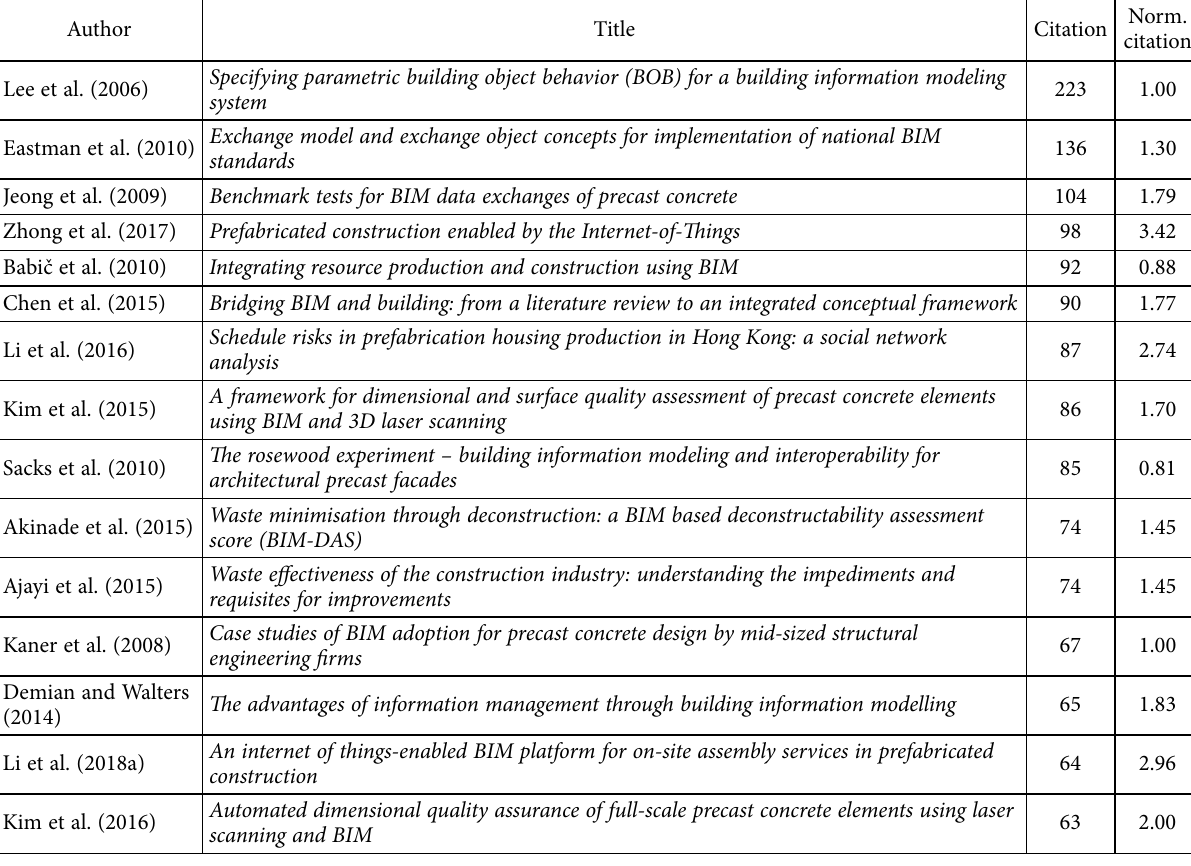
Table 2. Top 15 articles with the highest impact in BIM for